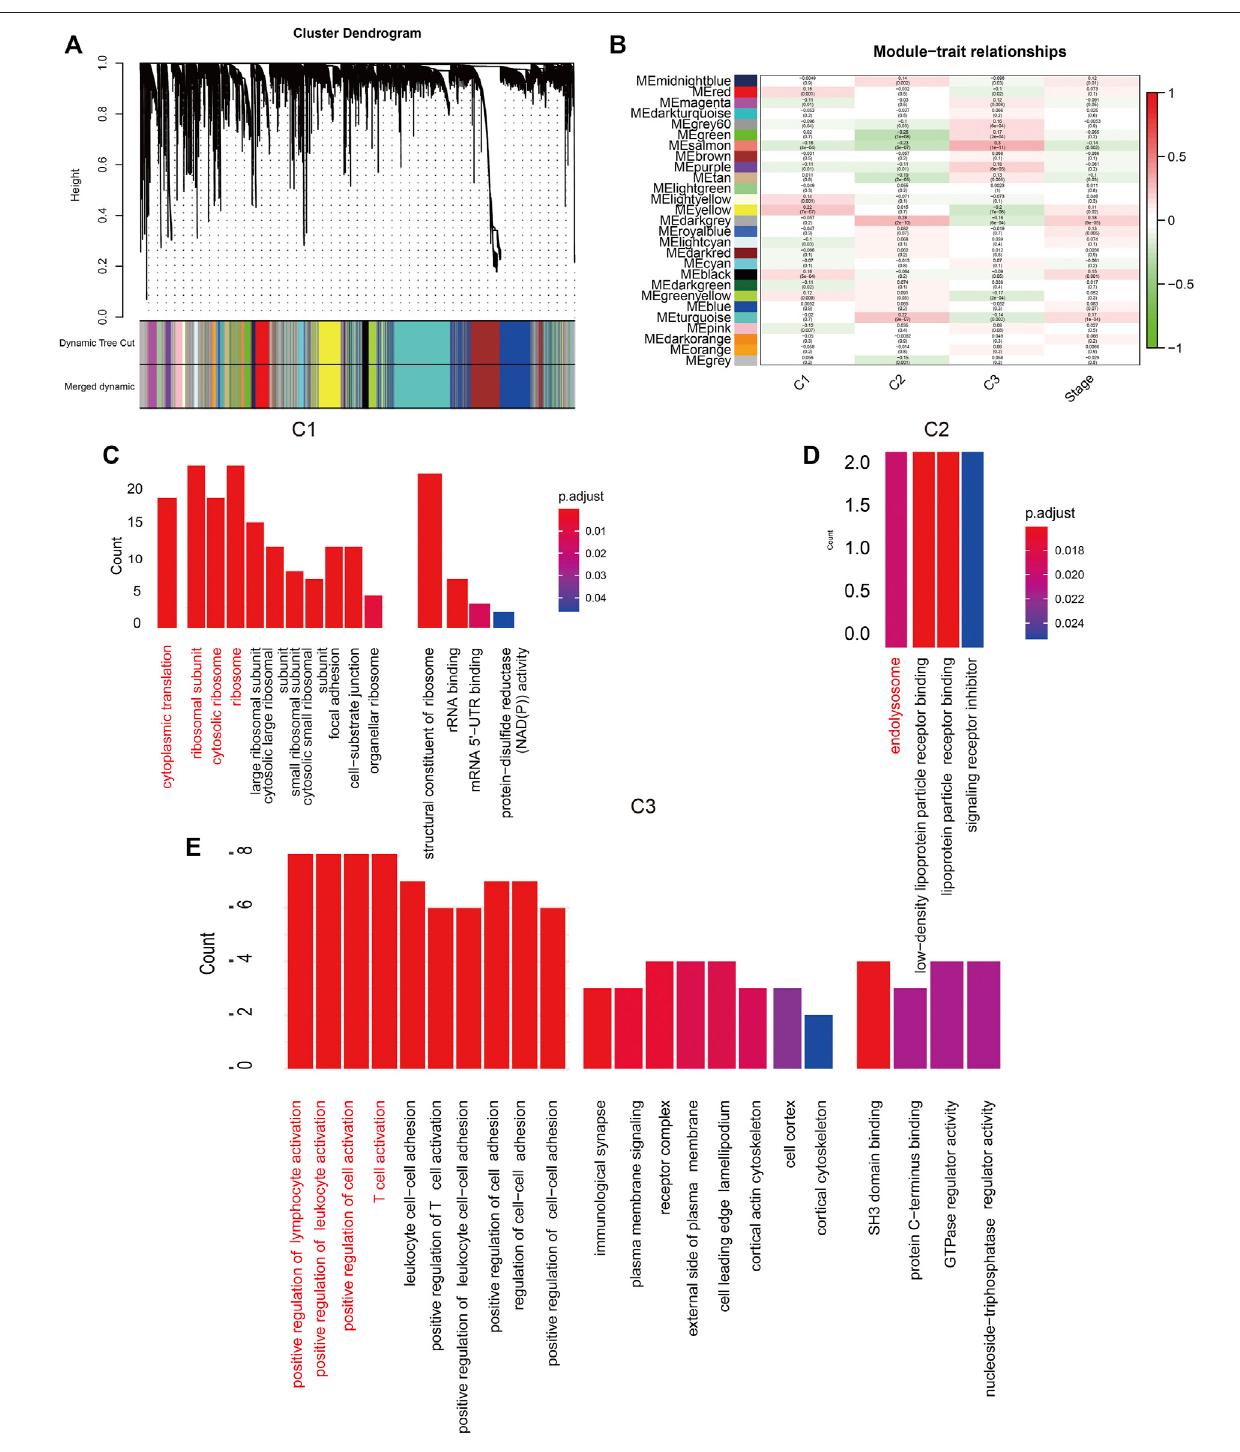
FIGURE 2 | (A) Hierarchical clustering tree. Each leaf represents a gene and each branch represents a co-expression module. (B) Twenty-seven co-expression modules were included. (C – E) : Signi fi cantly enriched biological processes, molecular functions and cellular components in C1, C2, and C3 groups.